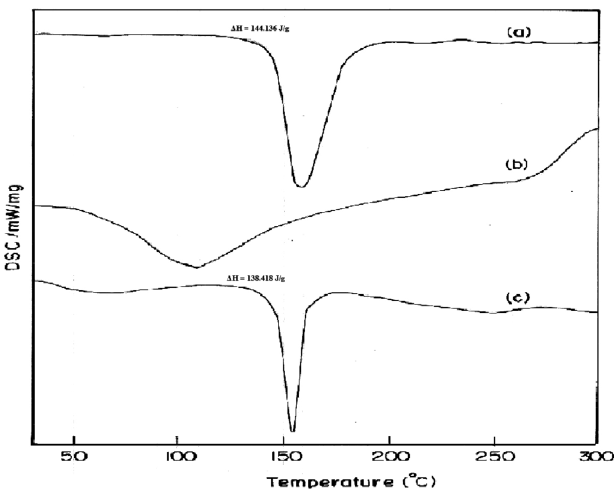
FIGURE 1 - DSC graphs of (a) Aceclofenac, (b) Xanthan gum, (c) Physical mixture of aceclofenac and xanthan